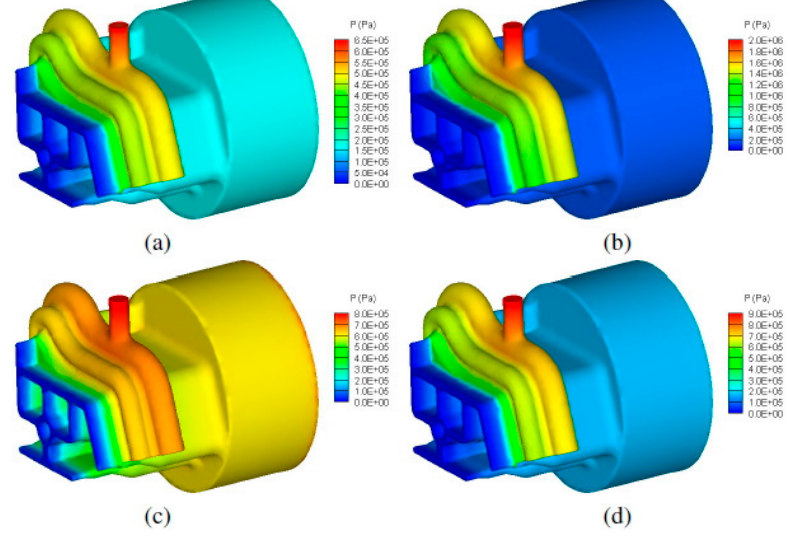
Figure 3. Modelling of pressure distribution in the profile die with ANSYS polyXtrue software by adapted from Gupta [65] with permission from Gupta, 2020. ( a ) Substrate: LDPE-A, Cap: LDPE-A, ( b ) Substrate: LDPE-A, Cap: LDPE-D, ( c ) Substrate: LDPE-D, Cap: LDPE-A, ( d ) Substrate: LDPE-A, Cap: LDPE-A with larger flow rate (LFR) through the cap